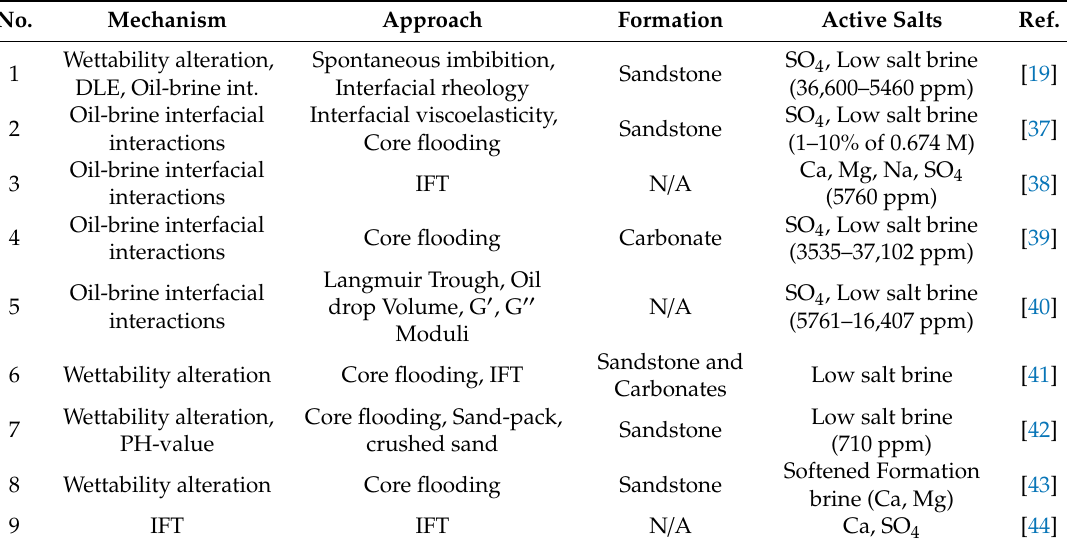
Table 1. Studies with focus on interfacial-interaction as a potential recovery